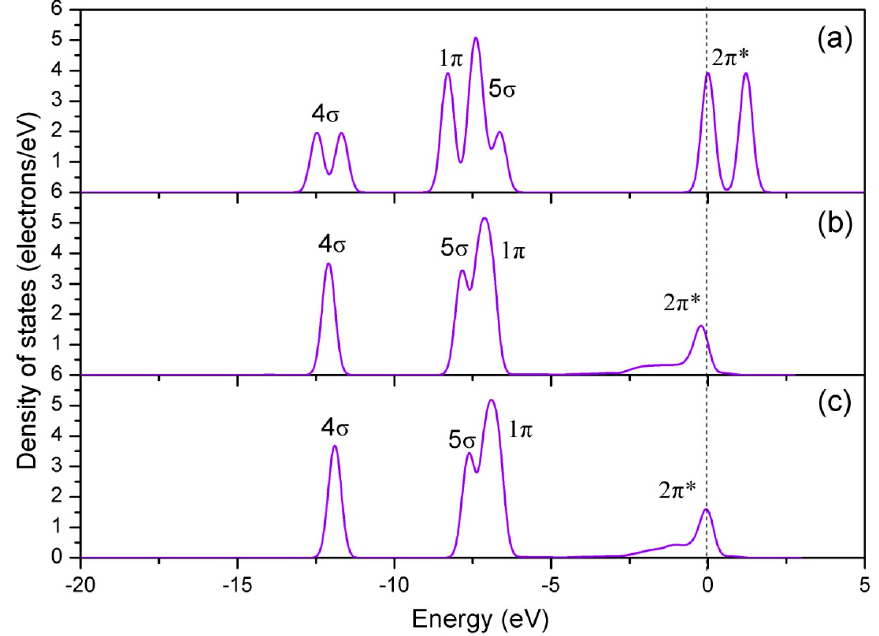
Figure 6. Density of states of the free and adsorbed NO: ( a ) Free, ( b ) perfect CoO 2 -terminated LaCoO 3 (011) surface, and ( c ) Ce-doped CoO 2 -terminated LaCoO 3 (011) surface.